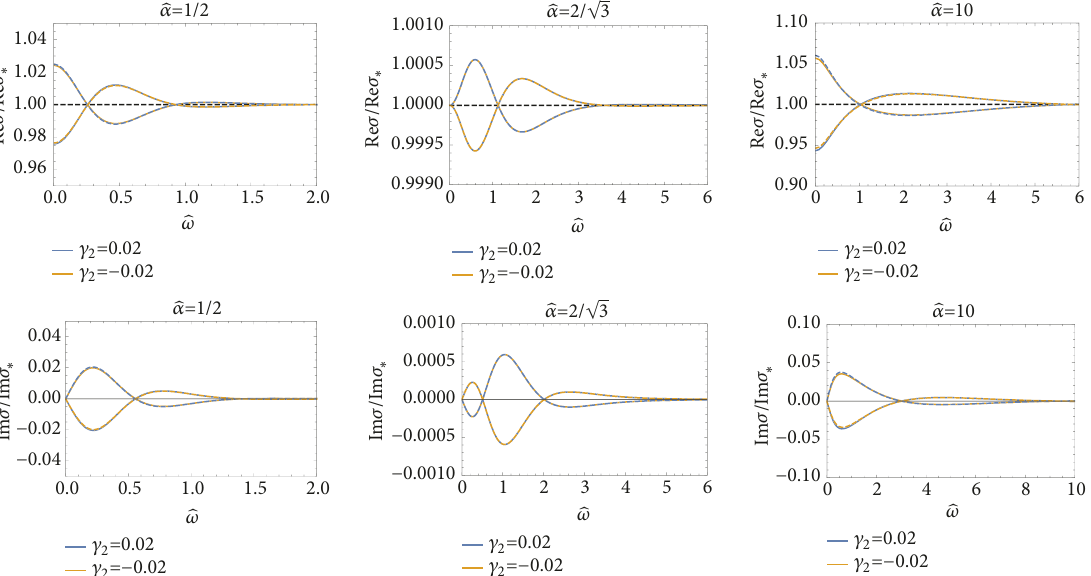
Figure 21: The real part (the plot above) and the imaginary part (the plot below) of the optical conductivity as the function of ̂𝜔 for |𝛾 2 | = 0.02 and various values of ̂𝛼 . The solid curves are the conductivity 𝜎 of the original EM theory (4) and the dashed curves display the conductivity 𝜎 ∗ of the EM dual theory (7).